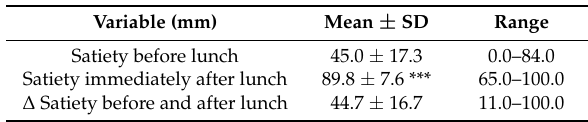
Table 2. Changes in satiety before and after